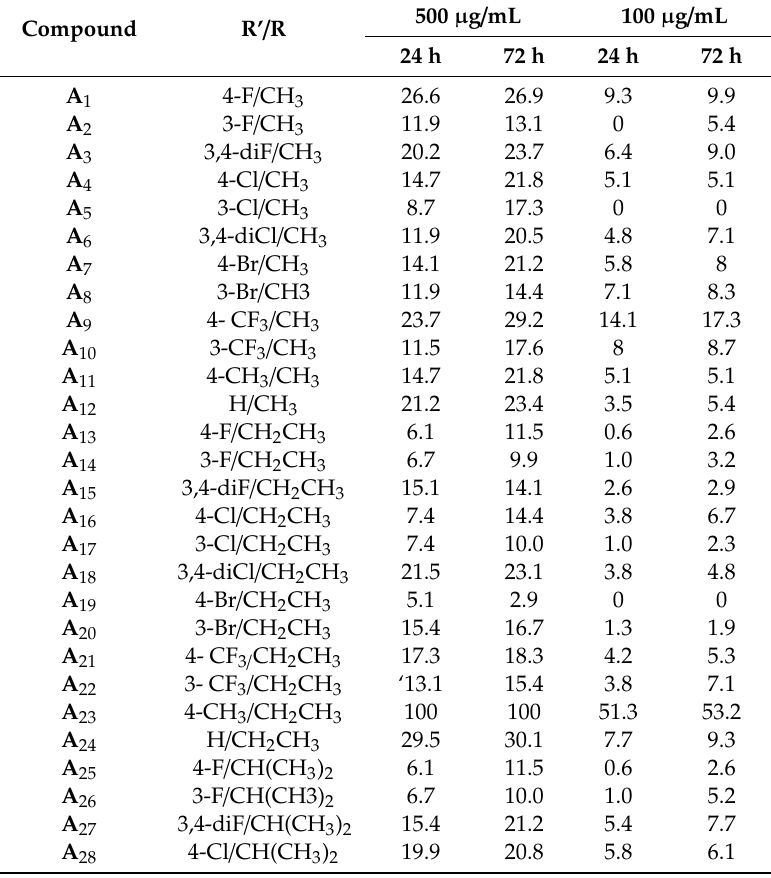
Table 2. Mortality (%) of the target compounds against M. incognita a .